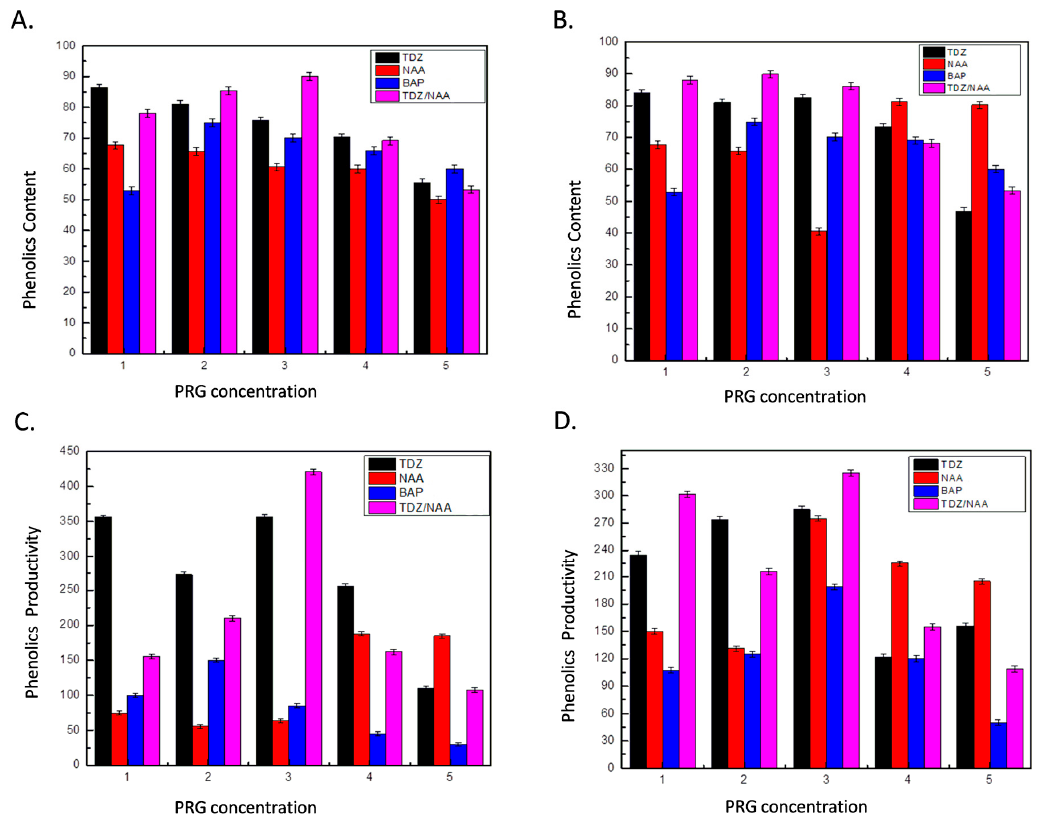
Figure 3. Comparison of total phenolic content (TPC) and total phenolic productivity (TPP) of extracts at different PGRs. ( A ) TPC (in mg/g DW) for stem-derived callus culture; ( B ) TPC (in mg/g DW) for